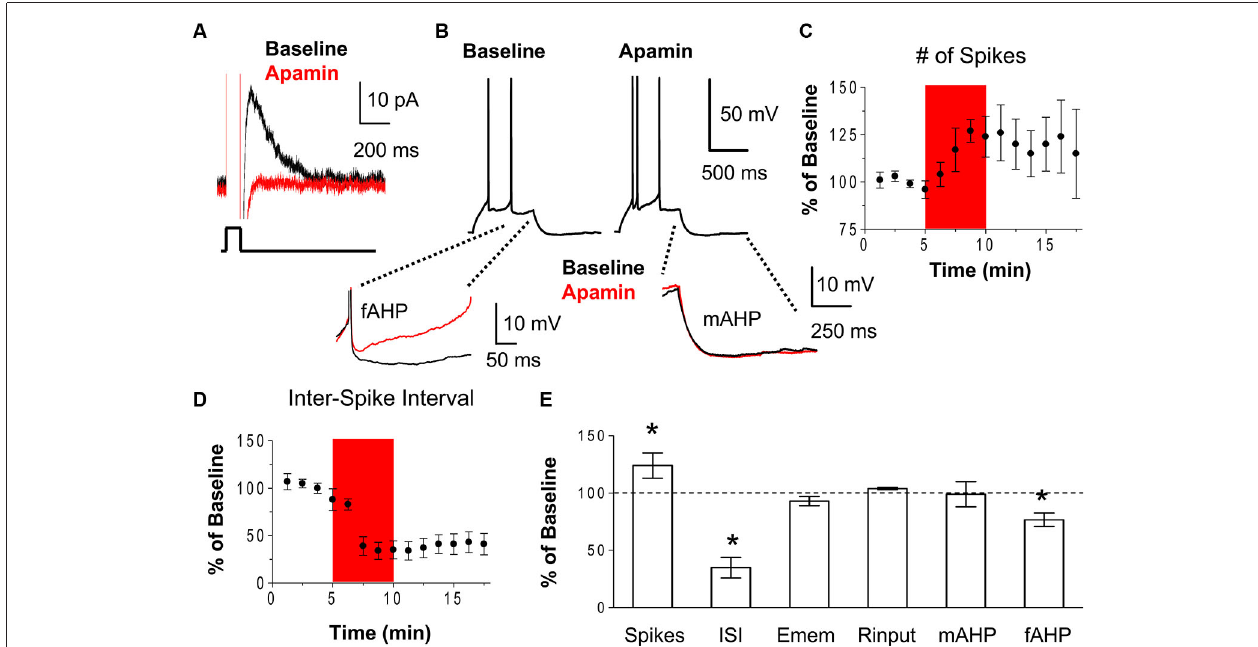
spike, and the mAHPs from the same traces. (C–D) Time courses showing that apamin (red area) persistently increased of the number of spikes and decreased the first ISI, consistent with enhanced bursting in IL neurons. (E) Summary of the effects of apamin on spike count, ISI, resting membrane potential (Emem), input resistance (Rinput), mAHP, and fAHP. n = 5; * p < 0.05.